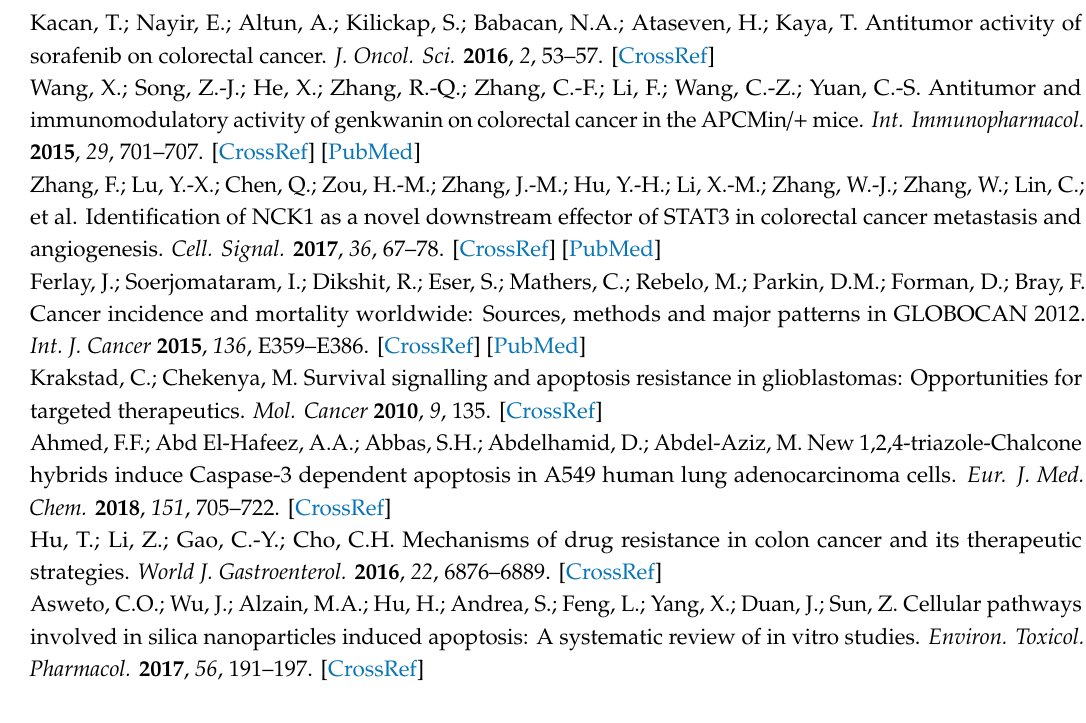
Figure S1. Mean cell proliferation of CT-26 cells treated with OXA for 24 h. (A) and 48 (B) hours. The concentrations used were: 5 µ g / mL, 10 µ g / mL, 25 µ g / mL, 50 µ g / mL, 100 µ g / mL, and 200 µ g / mL. All treatment groups were compared to the negative control group (**** p < 0.0001), Figure S2. Flow cytometry to determine apoptosis. Dot plots of flow cytometry with the e ff ect of di ff erent doses of OXA, DMSO, and NPs on early and late apoptotic CT-26 cells after 24 h. are displayed, Figure S3. Flow cytometry to determine apoptosis. Dot plots of flow cytometry with the e ff ect of di ff erent doses of OXA, DMSO, and NPs on early and late apoptotic CT-26 cells at 48 h are displayed, Figure S4. Flow cytometry to determine apoptosis. Dot plots of flow cytometry with the e ff ect of di ff erent doses